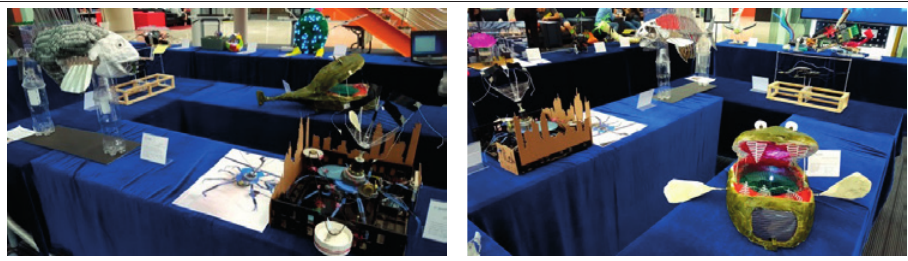
source of energy. Solar panels are installed on its wings. Microplastics are used as a source of energy. Green algae are used as a